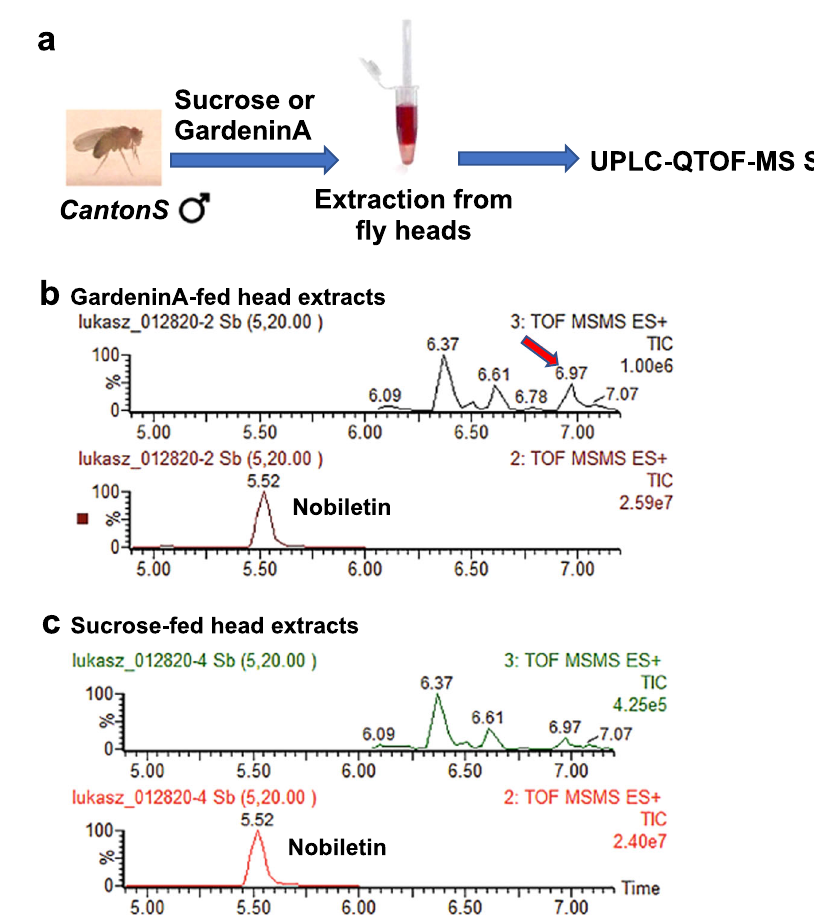
Fig. 6 Detection of GardeninA in the Drosophila heads using UPLC/QTOF/MS SIR. a Schematic representation of the feeding regimen. Adult male fl ies were either pre-fed for 4 days with 2.5% sucrose or GardeninA (10 μ M) followed by preparation of head homogenates using DMSO. Chromatograms of head homogenates from adult male fl ies pre-fed for 4 days with either b 10 μ M GardeninA or c 2.5% sucrose followed by extraction and analysis using UPLC/QTOF/MS in positive ionization